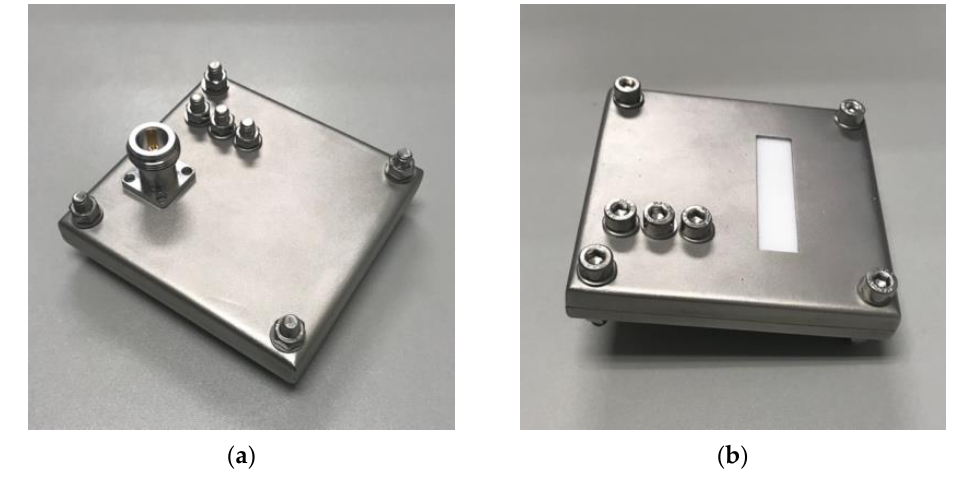
Figure 4. ( a ) Top view of the manufactured antenna; ( b ) Bottom view of the manufactured antenna.